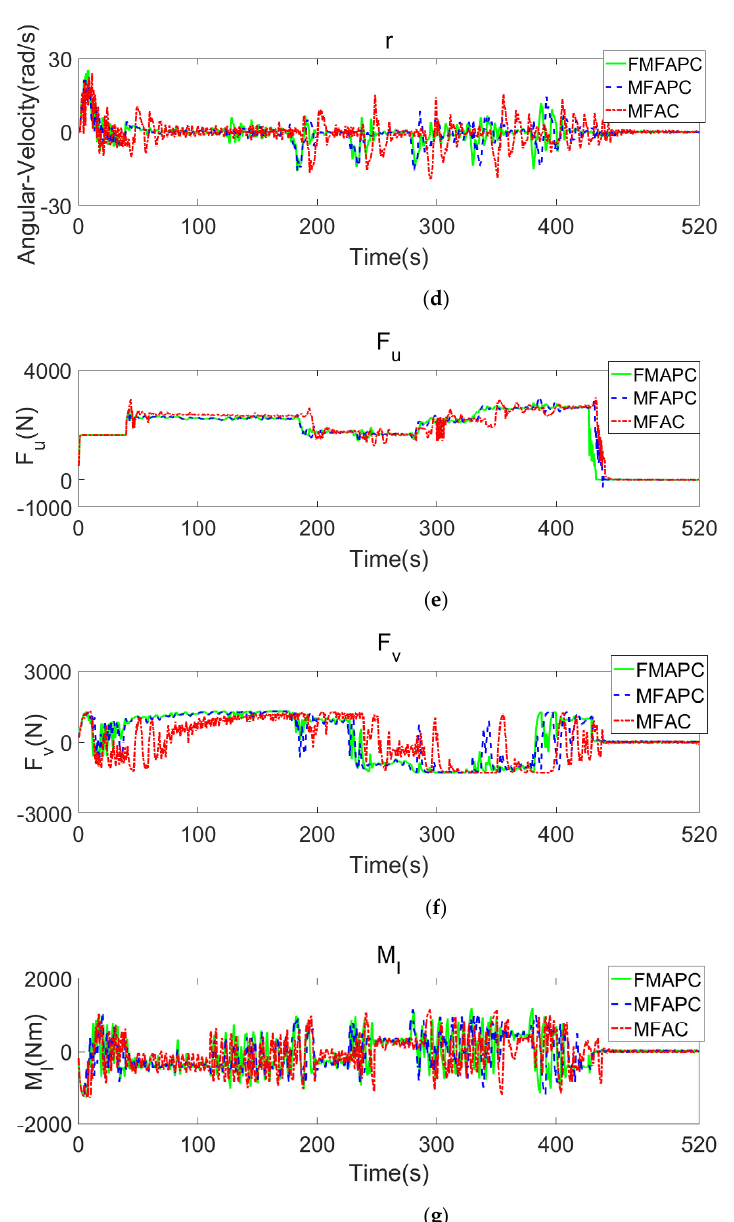
Figure 3. Simulation results of scenario 2. ( a ) Tracking results of comb ‐ shaped trajectory. ( b − d ) Control outputs. ( e − g ) Control inputs.